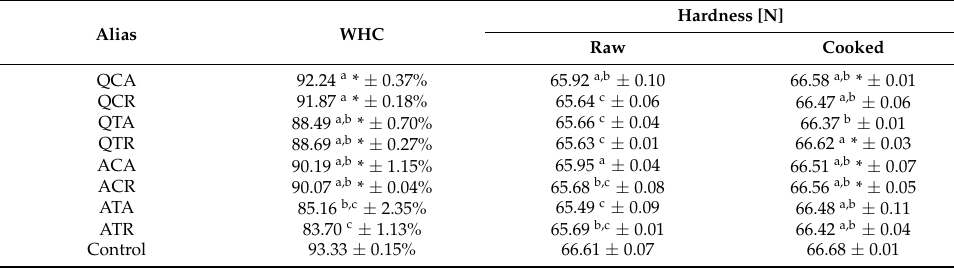
Table 5. Results for water holding capacity for raw formulations and hardness for raw and cooked